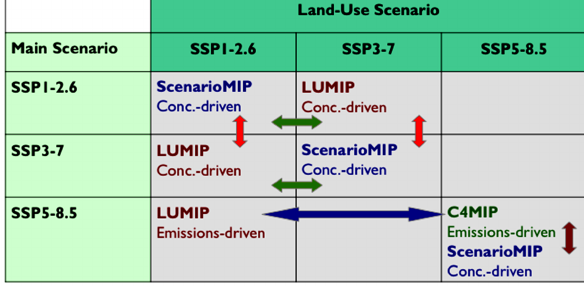
Figure 5. Schematic describing the future land-use policy sensi- tivity experiments. Green arrows indicate set of experiments that permit analysis of the biogeophysical climate impacts of projected land use and enable assessment of land management as a regional climate mitigation tool. Red arrows indicate set of experiments that allow study of how the impact of land-use change differs at different levels of climate change and at different levels of CO 2 concentra- tion. Blue arrow indicates set of experiments that will enable quan- tification of the full effects of a different land-use scenario through both biophysical and biogeochemical processes. Brown arrows indi- cate set of experiments that allow quantification of the effects of the climate-carbon cycle feedback on future CO 2 and climate